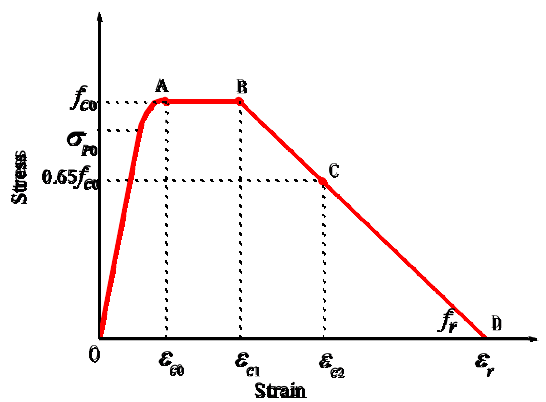
Figure 2. Proposed stress–strain model of confined well cement.